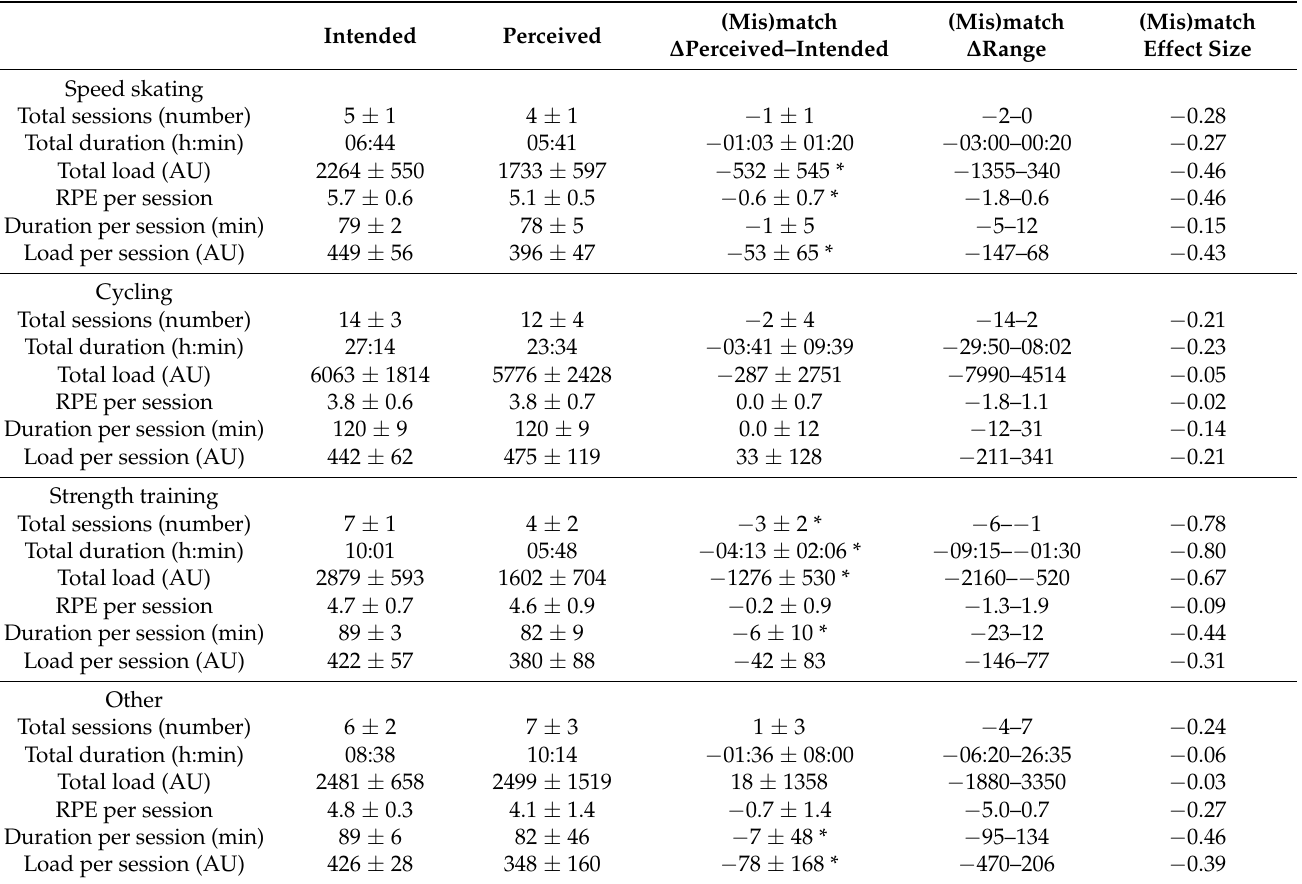
Table 2. Mean values of intended and perceived training variables for 14 speed skaters along with the difference between training variables (perceived minus intended) for different training modalities over four weeks, mean ± SD shown.